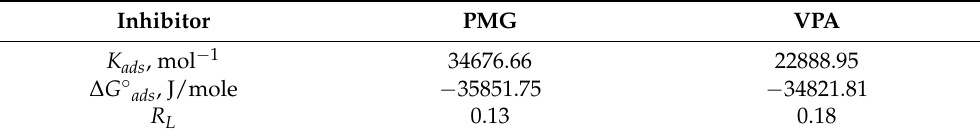
Table 3. Adsorption parameters ( K ads , R L and ∆ G ◦ ads ) for PMG and